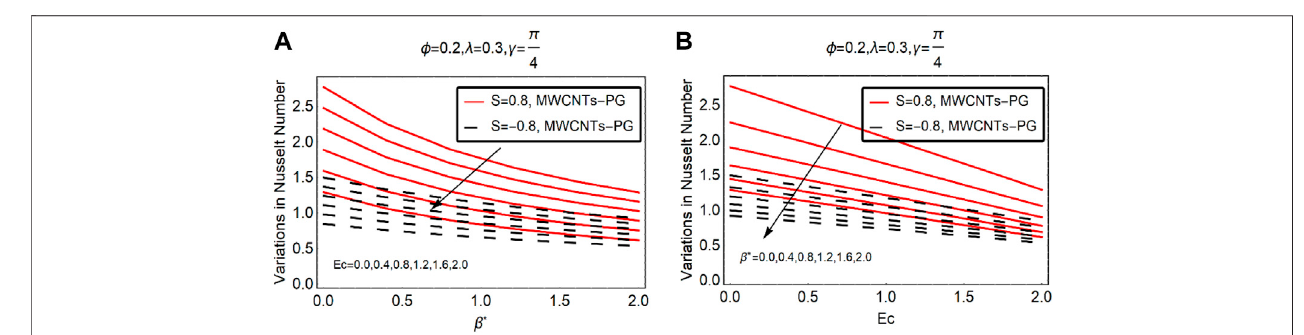
FIGURE 9 | The local thermal performance rate against (A) Ec and (B) β p .